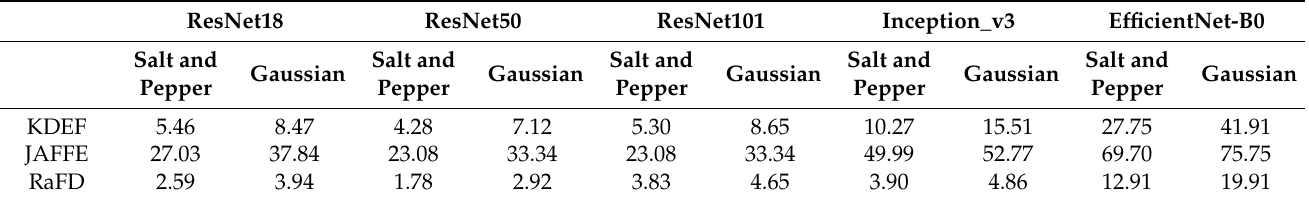
Table 7. Percentage deviation of classification accuracy with corrupted test images for each CNN per database.